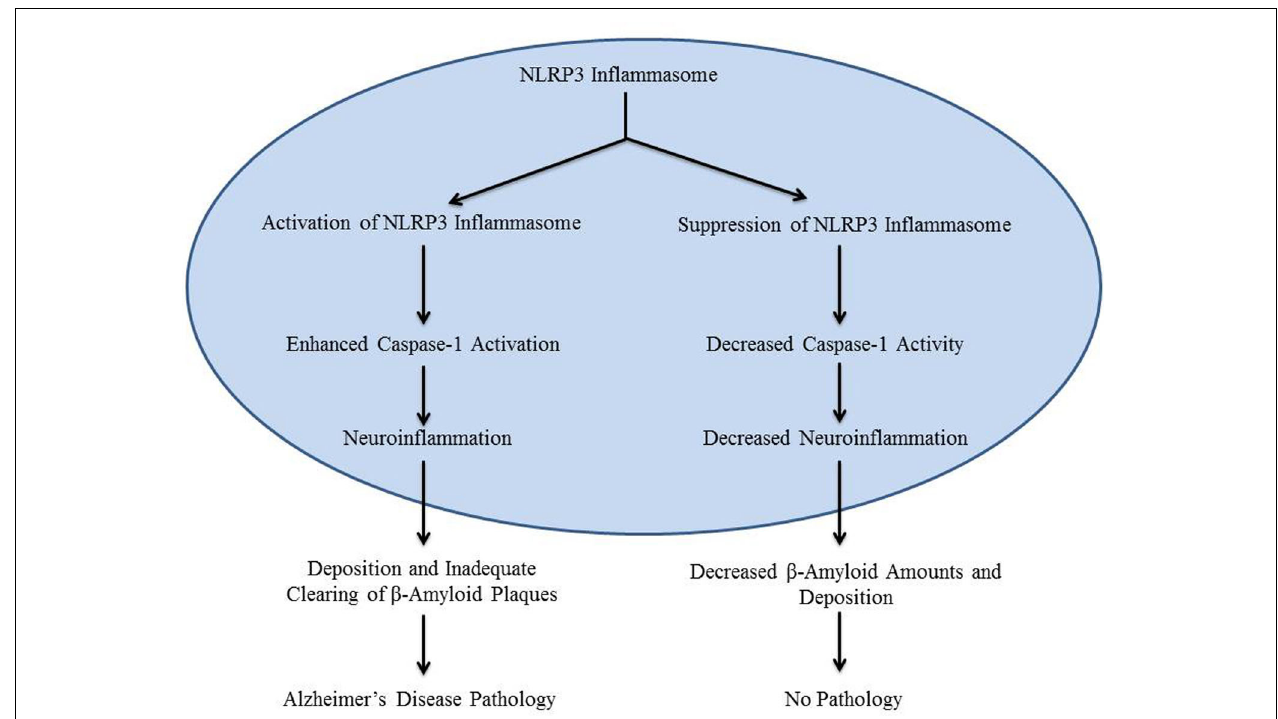
FIGURE 1 | The diagram is a schematic representation of the role of NLRP3 inflammasome in Alzheimer’s disease. found to have delayed